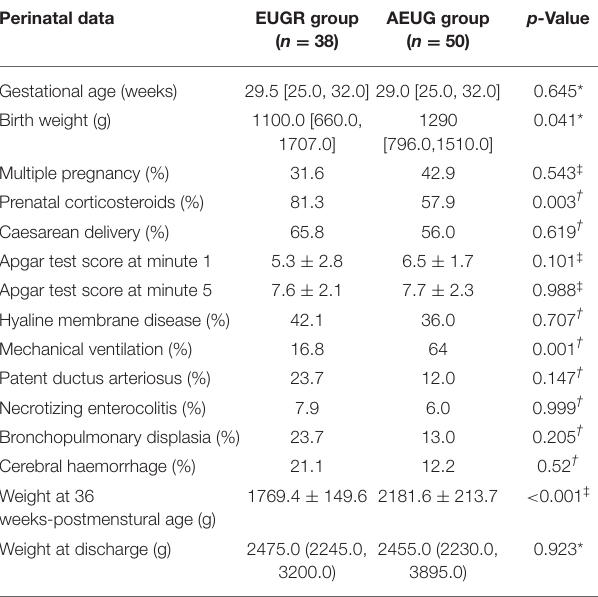
TABLE 1 | Perinatal data of children with a history of prematurity and extrauterine growth restriction (EUGR group) and those with prematurity and adequate extrauterine growth (AEUG group).